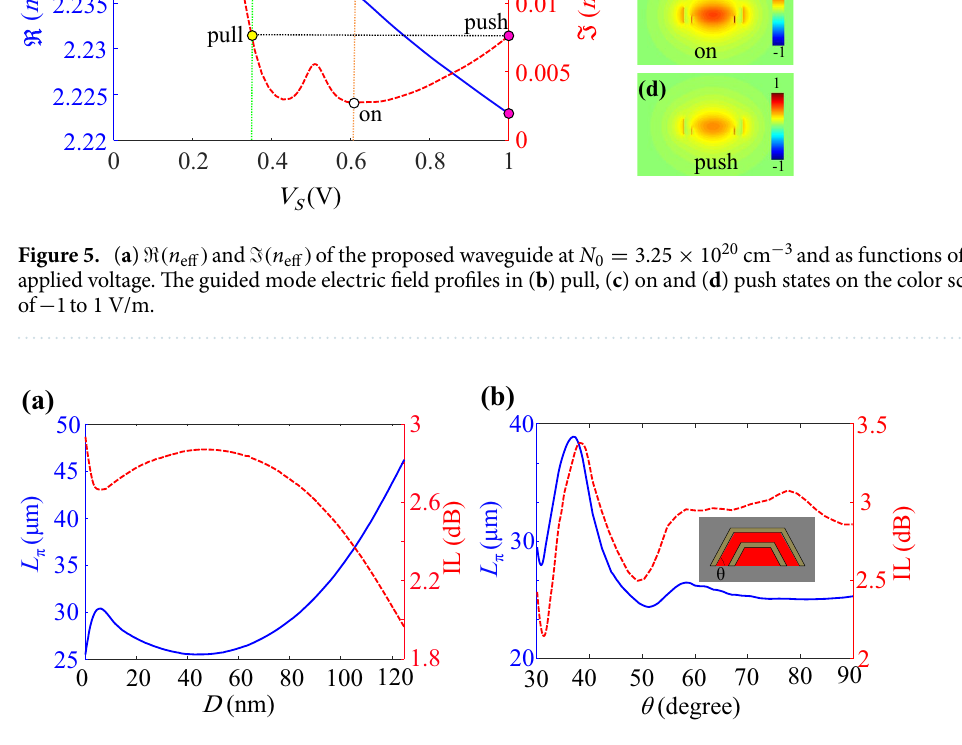
Figure 6. ( a ) Required arm length for π phase shift ( L π ) and its associated IL as functions of aSi thickness. ( b ) L π and IL versus the side wall angle. The inset shows the cross section of waveguide where the Si, stack of thin materials and SiO 2 are respectively represented by red, brown and grey